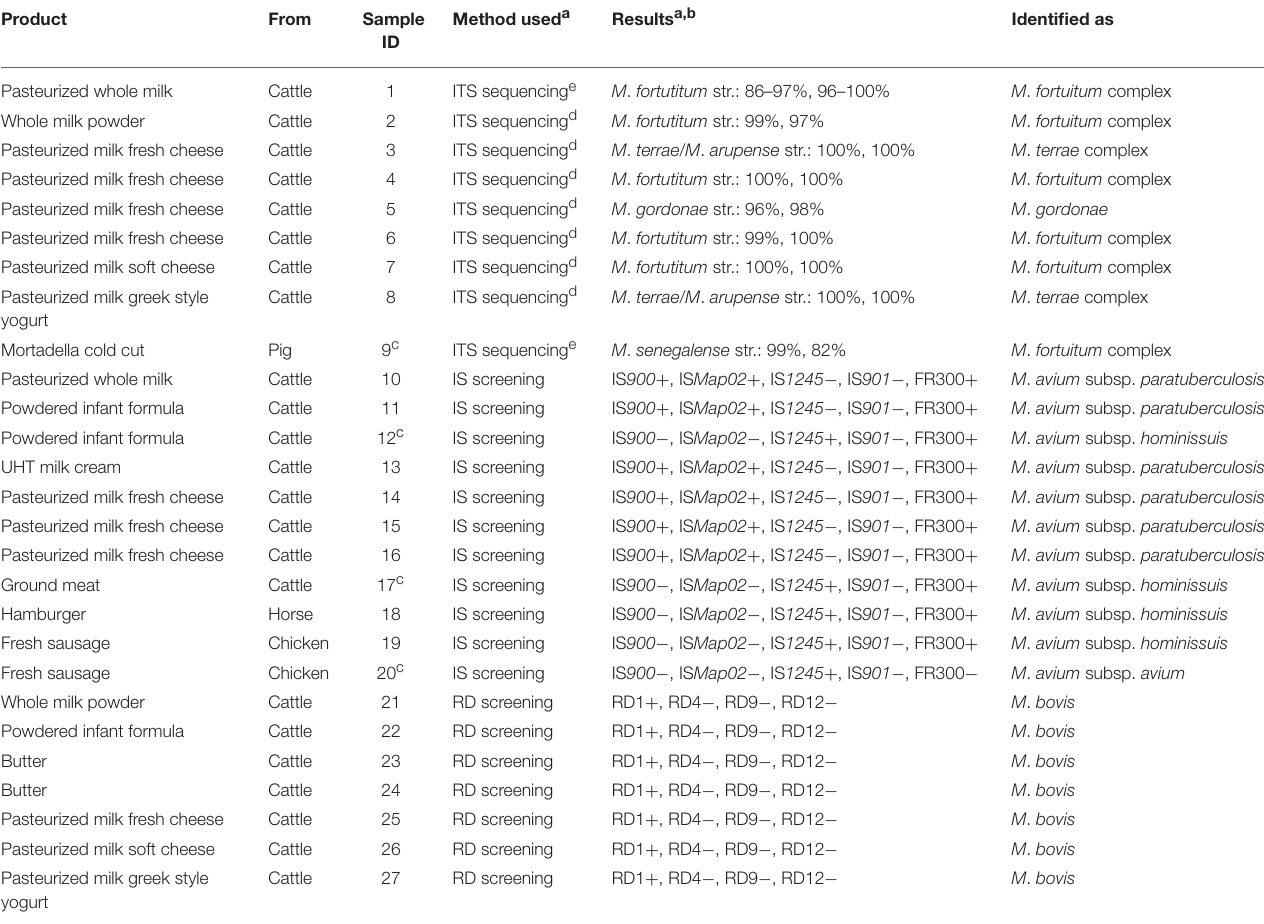
TABLE 3 | Confirmation and identification of samples positive to either culture or screening tetraplex real-time PCR. Product From Sample Method used a Results a,b Identified ID